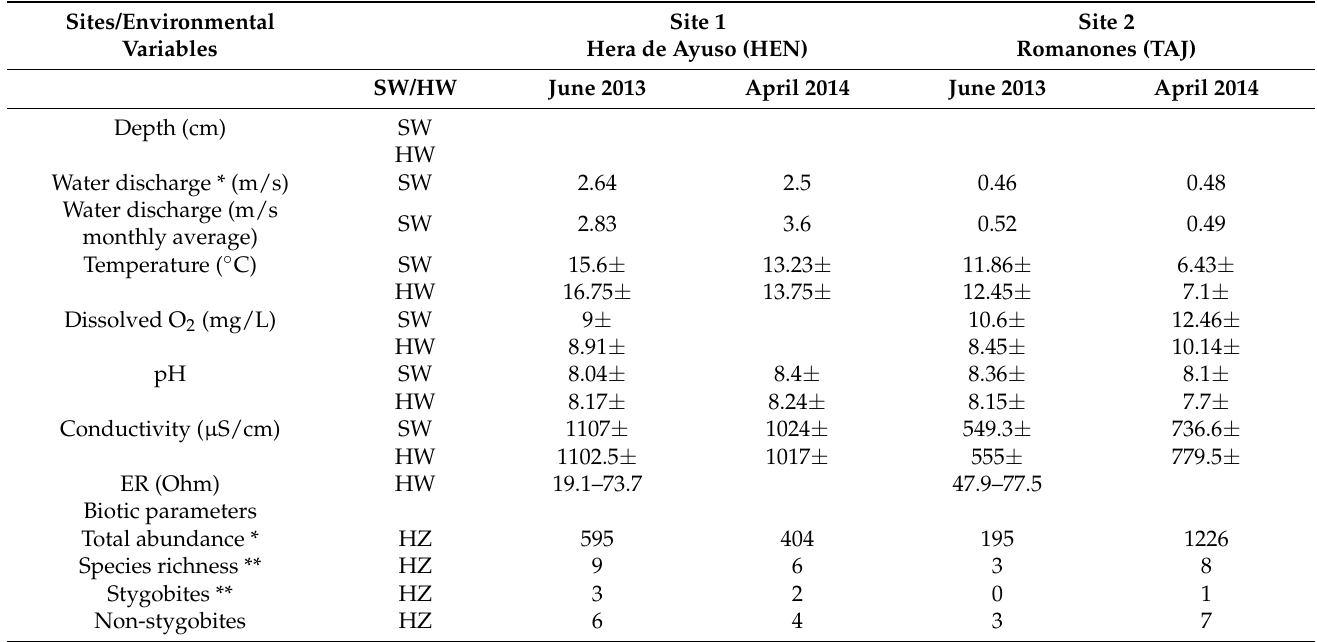
Table 2. Environmental variables and biotic parameters in the investigated